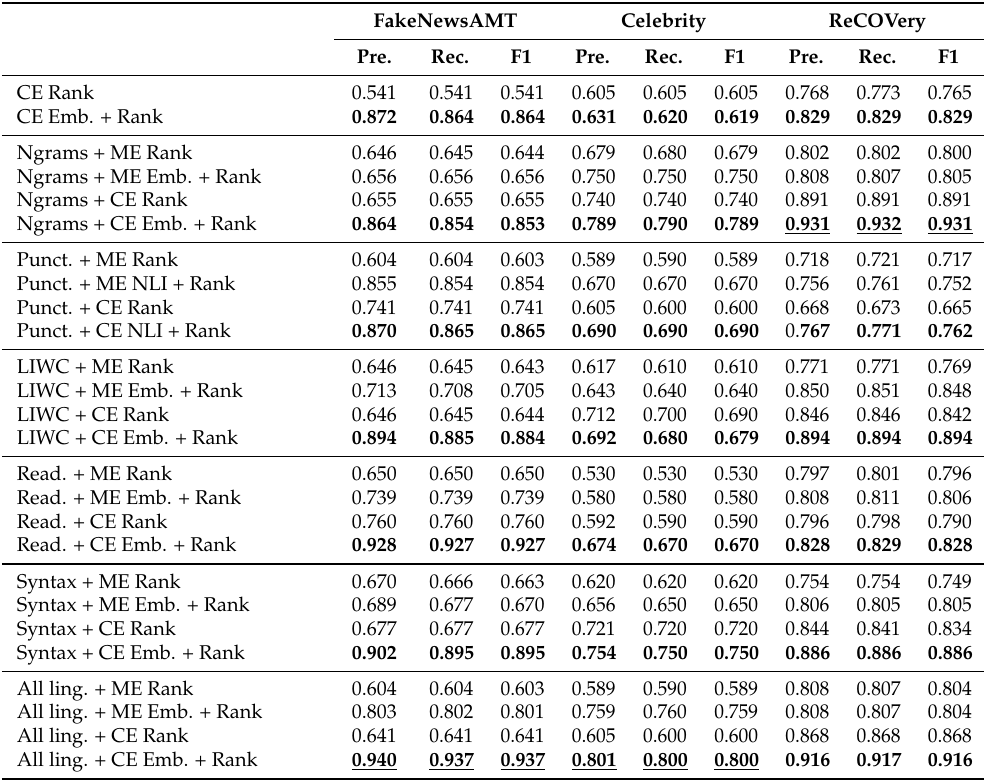
Table 6. Results of the ablation study—the use of the best feature sets with cross-lingual evidence (CE) and source rank (Rank) compared with the use of monolingual evidence (ME) and the source rank. The bold numbers indicates the best results in the block, the bold and underlined —the best result for the dataset. We can see that the performances of only source ranks or monolingual evidence are significantly worse than the use of our proposed feature for all